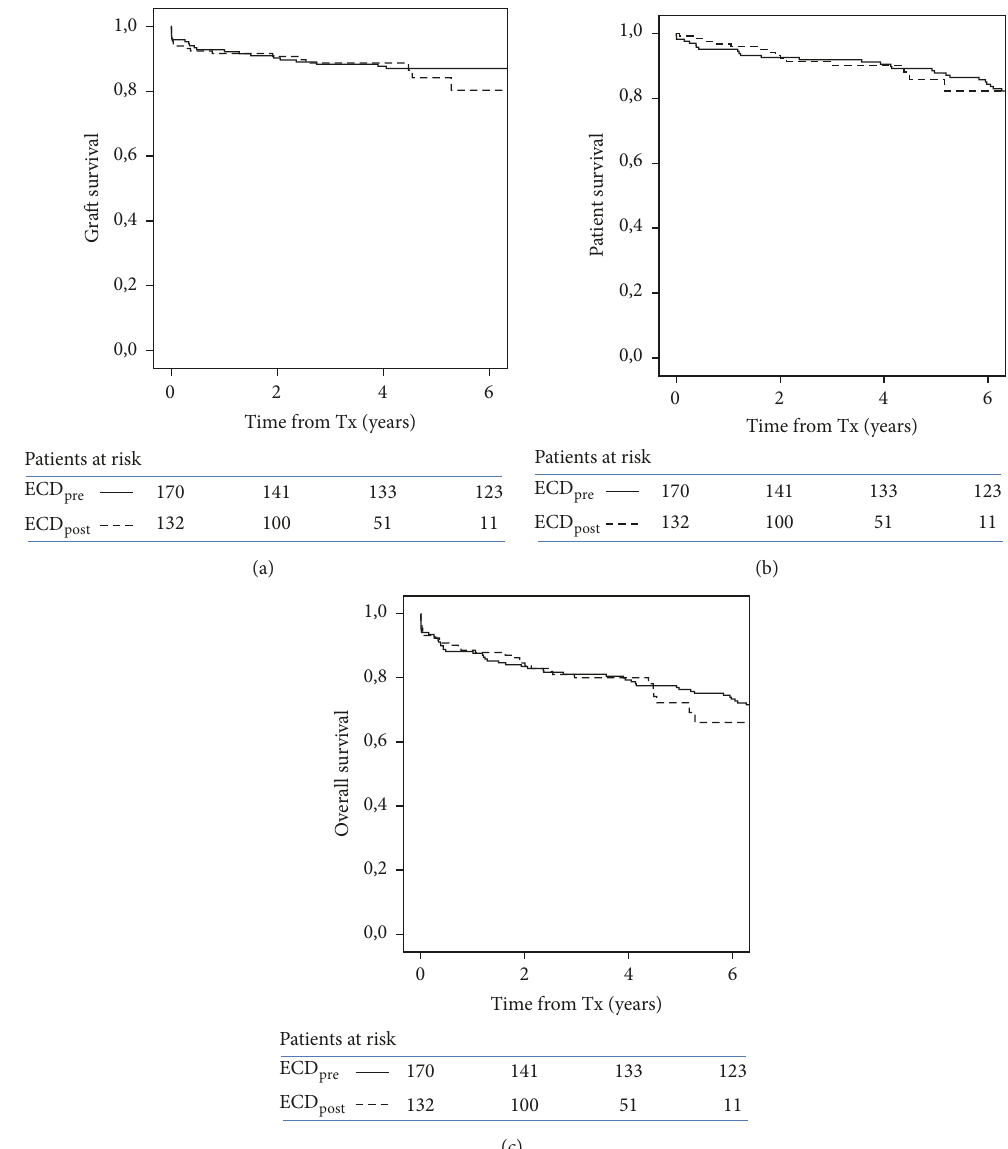
Figure 1: Kaplan-Meier plots of graft (death-censored) (a), patient (b), and overall survival (c) in transplant recipients of ECD organs according to period (ECD : pre-DKT period; ECD : DKT pre post